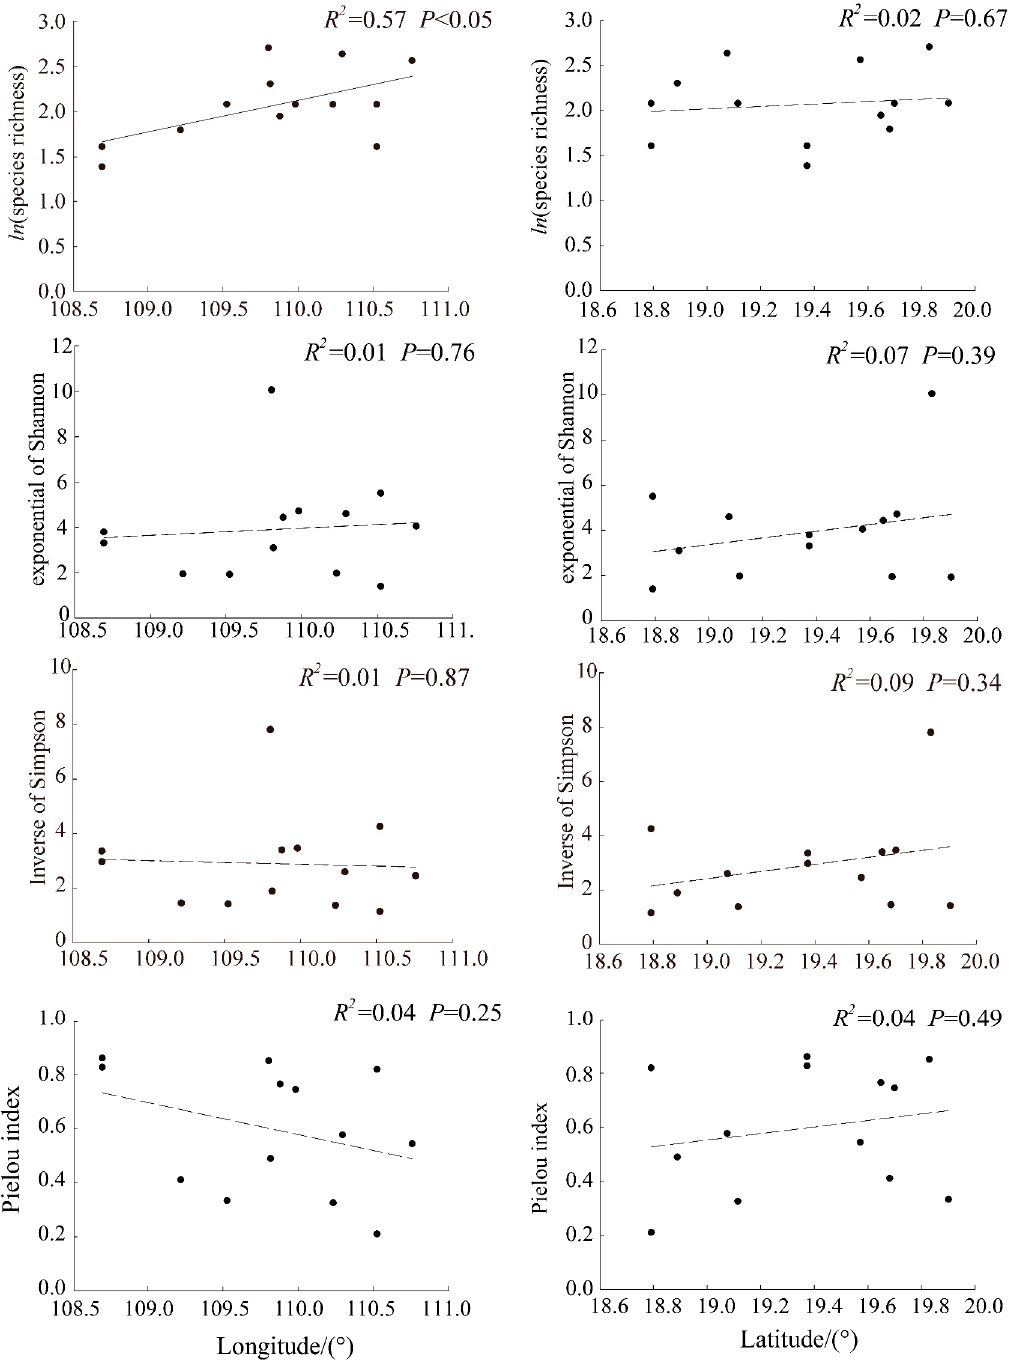
Figure 2. The species diversity indices change along the longitude and latitude. Note: • represents one of 13 sample plots.